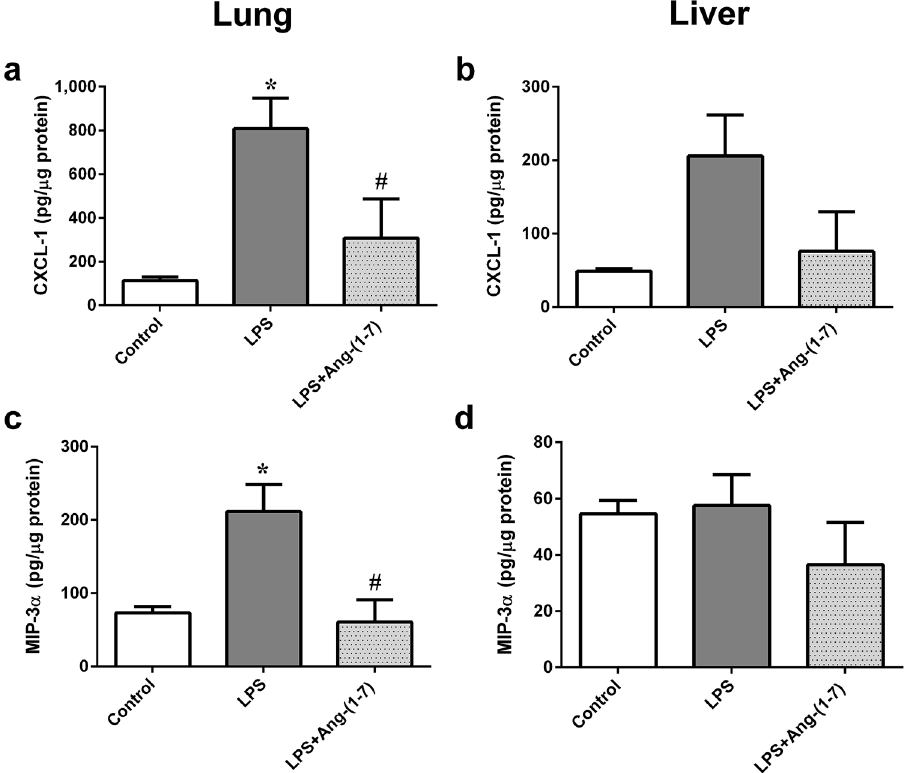
Figure 6. Angiotensin-(1–7) attenuated elevated tissue levels of CXCL1 and macrophage-inflammatory protein (MIP)-3α in endotoxaemic rats. We assessed the changes in lung CXCL1 ( a ), liver CXCL1 ( b ), lung MIP-3α ( c ), and liver MIP-3α levels in rats infused with 0.9% NaCl (control, n = 3), E. coli lipopolysaccharide (LPS, 10 mg/kg for 15 min, n = 3), or LPS plus Ang-(1–7) (1 mg/kg for 3 h at 0.5 h after LPS, n = 3). Lung and liver tissues were harvested 6 h after LPS administration. The data are shown as the mean ± standard error of the mean. *, p < 0.05 for LPS vs. control. # , p < 0.05 for LPS + Ang-(1–7) vs. LPS.